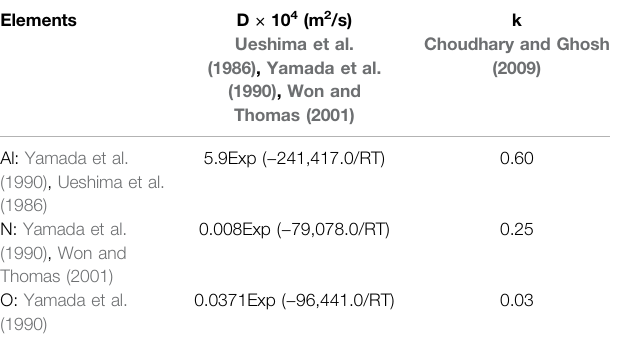
TABLE 3 | Partition coef fi cients (k) and diffusion coef fi cients (D) in delta phase of solute elements. Elements